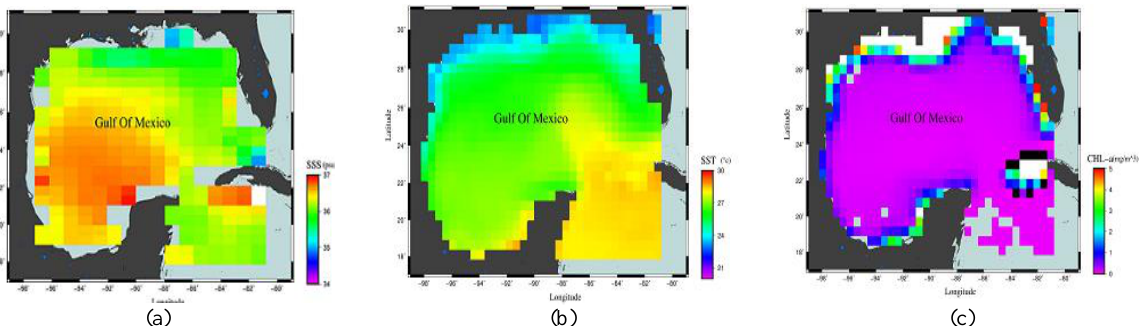
Figure 6. Spatial distribution of the 3-year averaged (a) SSS, (b), SST, and (c) CHLa in Gulf of